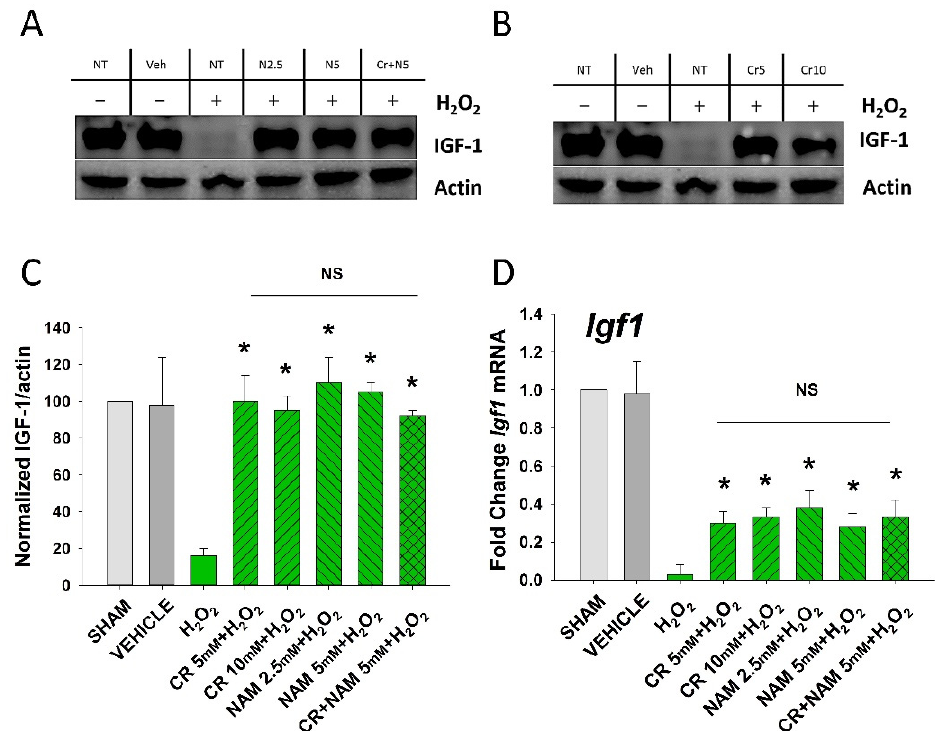
Figure 4. Effect of Cr and NAM on oxidant induced senescence-associated decreases in IGF-1 levels. DHF were exposed to various concentrations of Cr or NAM alone or combined (5 mM each), media alone (SHAM), or water vehicle (1%). After 24 h, the cells were exposed to 600 µM H 2 O 2 for 2 h, followed by harvesting 72 h later ( A , B ). Examples of Western blotting indicating that H 2 O 2 treatment decreased IGF-1 protein expression whereas pretreatment with ( A ) Cr and ( B ) NAM normalized IGF-1 protein levels; ( C ) graphical summary of ( A , B ) normalized (to actin) protein levels. Data sets of IGF-1 levels were quantified relative to actin and normalized to sham ( D ) IGF-1 mRNA was decreased by H 2 O 2 but Cr and NAM pretreatment blunted the decrease of IGF-1 mRNA levels. Data sets of IGF-1 mRNA were quantified using the Livak method and normalized to sham. The data are mean ± SE from 3–4 separate experiments using duplicate samples. * Denotes statistically significant changes in the Cr/NAM treated levels in comparison to H 2 O 2 alone. NS, the treatments compared are not statistically significantly different.